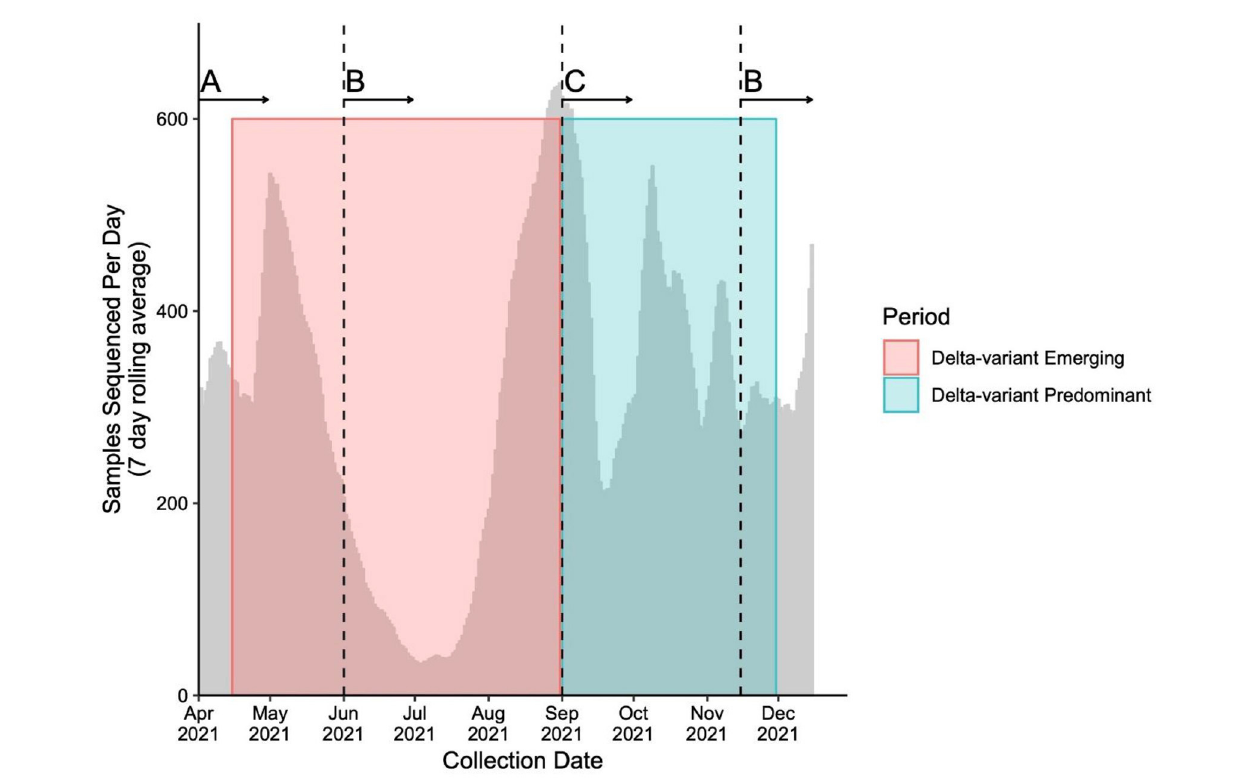
FIGURE 1 | Number of samples sequenced (7 day rolling average) during study period. Sequencing strategies throughout the study periods adapted to changes in testing guidelines and sequencing capacity to capture the evolution of the pandemic. The number of averaged sequenced samples is plotted by time overlapping the Delta-variant emerging (pink box) and predominant (blue box) periods. The vertical dashed lines represent the time when whole genome sequencing (WGS) strategy changed. The sequencing strategies include (A) a combination of targeted qPCR-based single-nucleotide polymorphism (SNP) and WGS of between 30 and 78% of all positive SARS-CoV-2 samples, (B) WGS of all positive SARS-CoV-2 samples and (C) WGS of all positive SARS-CoV-2 samples on the first week of the month, and WGS of a representative subset of 10% of all positive SARS-CoV-2 samples for the second, third and fourth week of the